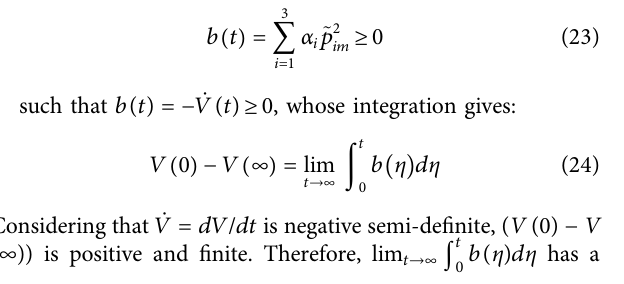
Frontiers in Robotics and AI |